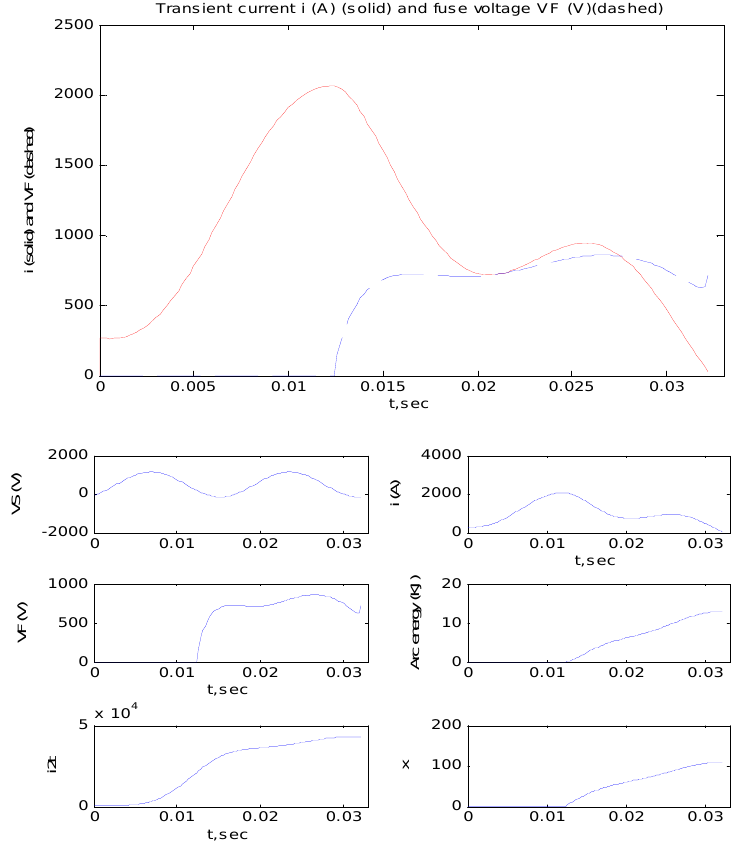
Figure 4. The transient current and fuse voltage if only one fuse in series with the semiconductor device at F1 was used to clear the